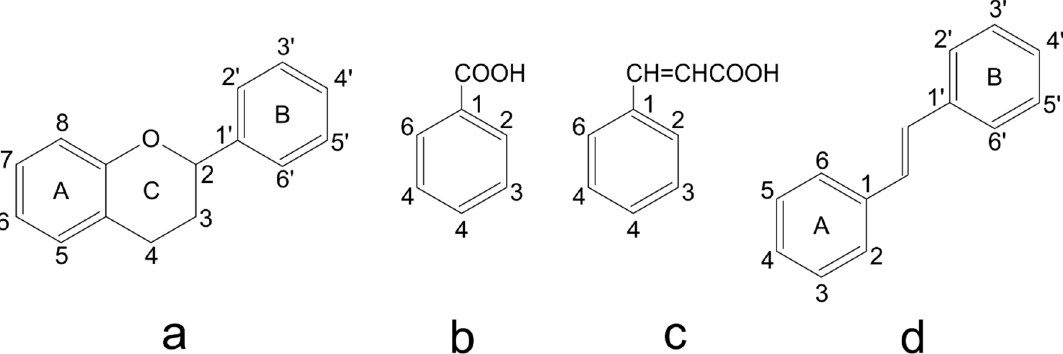
Figure 3. Basic structure of ( a ) flavan, ( b ) benzoic acid, ( c ) cinnamic acid, and ( d )